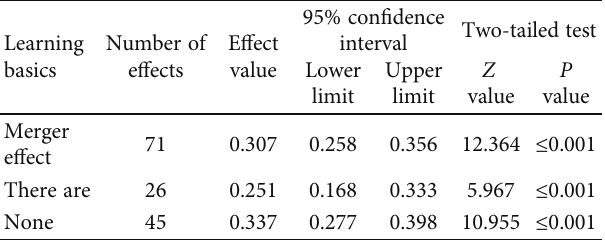
Table 7: E ff ects of di ff erent prior experiences. Learning